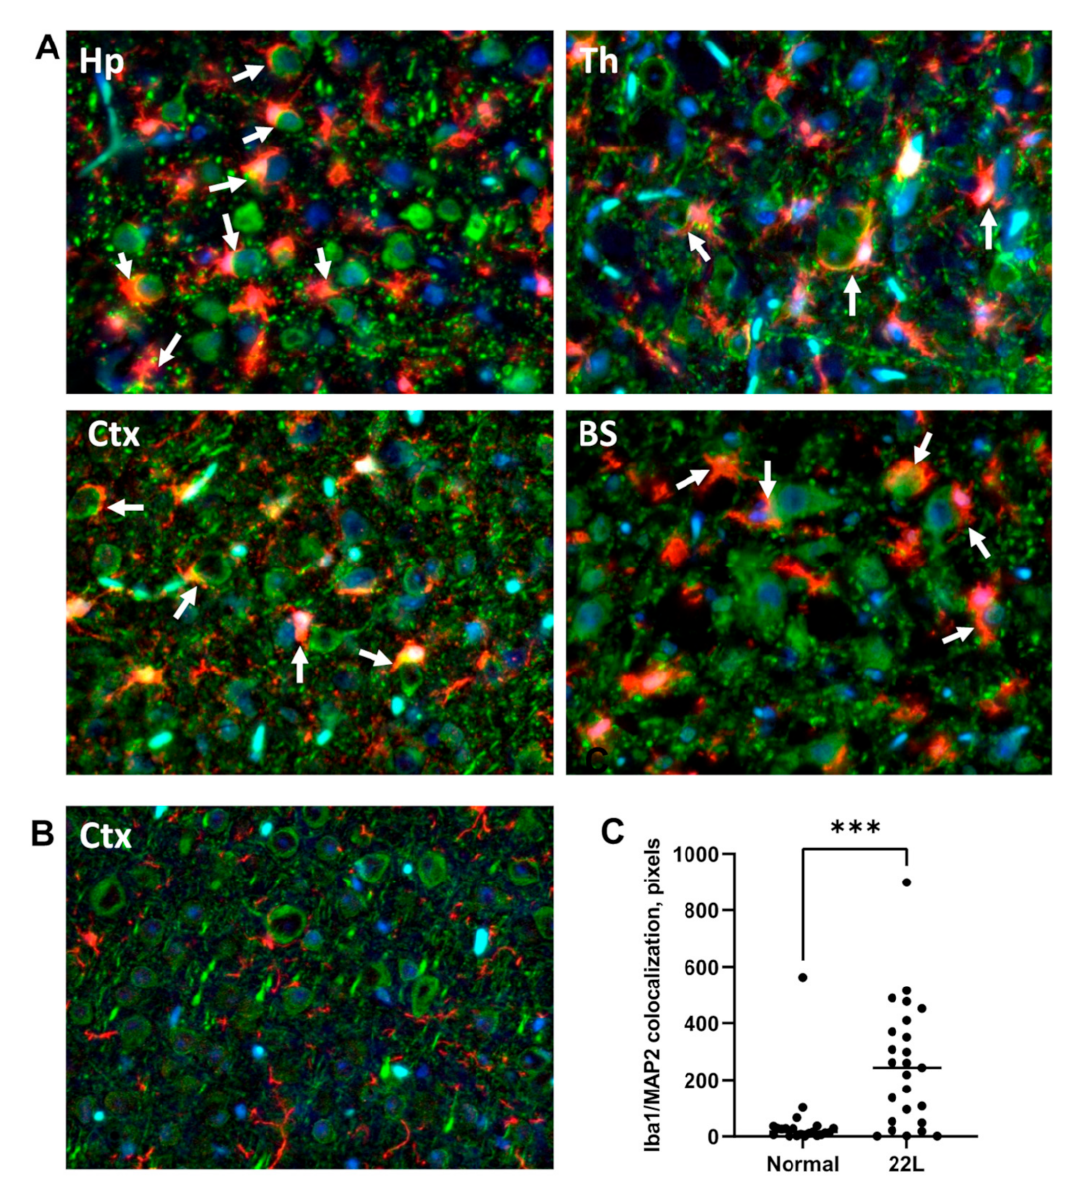
Figure 5. Engulfment of neuronal cells by reactive microglia in vivo. Co-immunostaining of 22L-infected mice ( A ) and age-matched controls ( B ) for microglia (Iba1, red), neurons (MAP2, green), and nuclei (DAPI, blue). In 22L-infected animals, microglia are often found in close vicinity to neuronal cell bodies or engulfing neuronal cell bodies, as pointed by white arrows. ( C ) Colocalization analysis of Iba1 and MAP2 in cortex. *** p < 0.001 (by unpaired t - test with Welch’s correction). Hp–hippocampus, Th–thalamus, Ctx–cortex, BS–brain stem. Scale bar: 50 µ